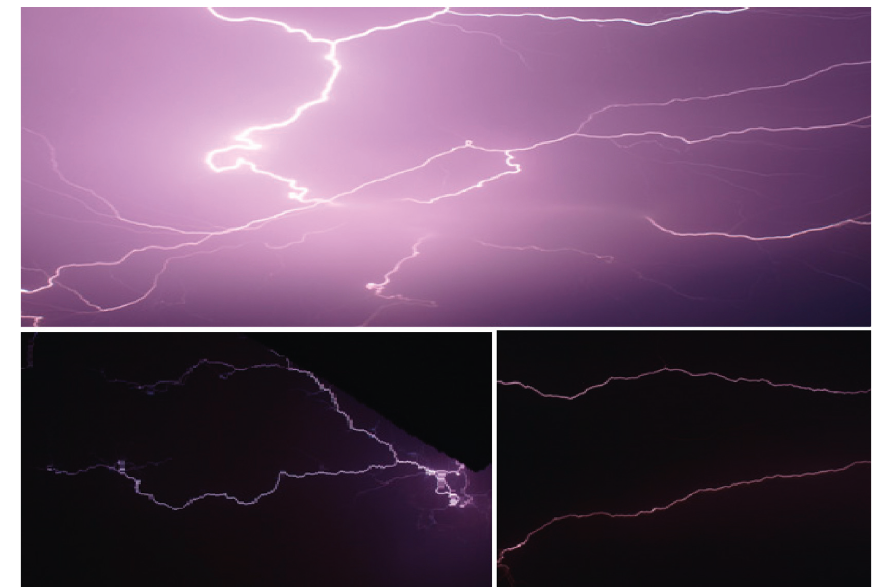
Figure 1: Example of cloud flashes showing variability from flash to